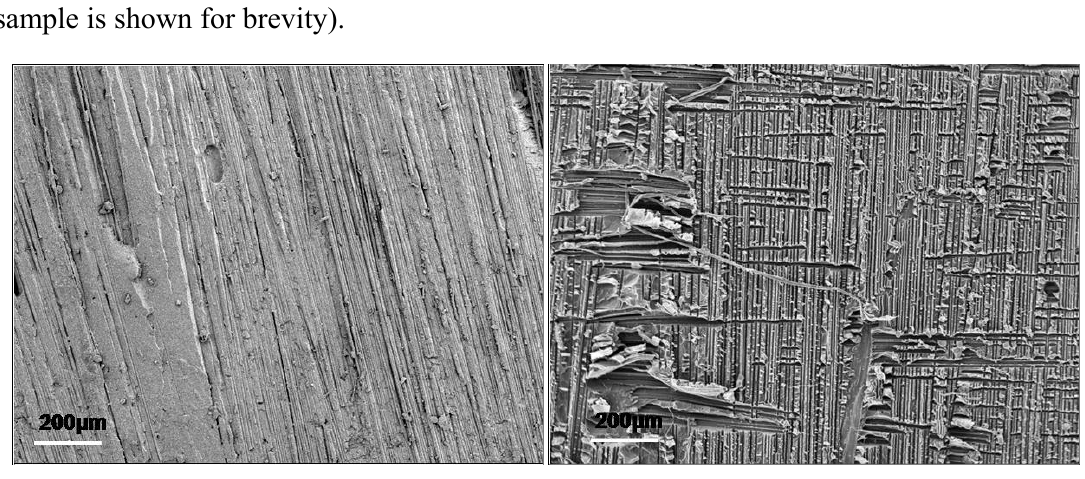
) results for the reference composite and a IIc